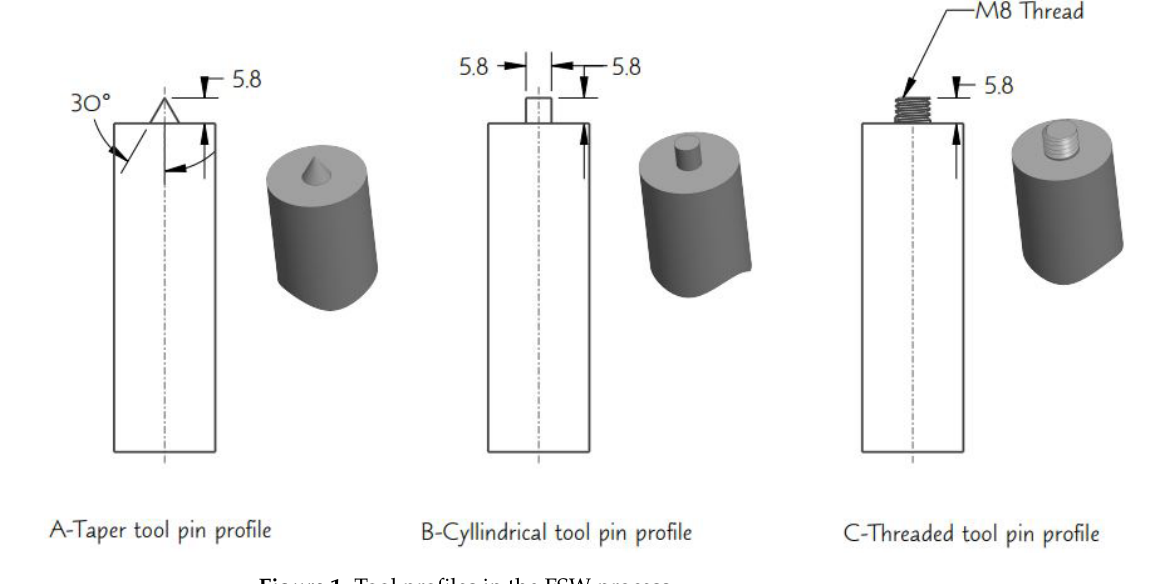
Figure 1. Tool profiles in the FSW process.